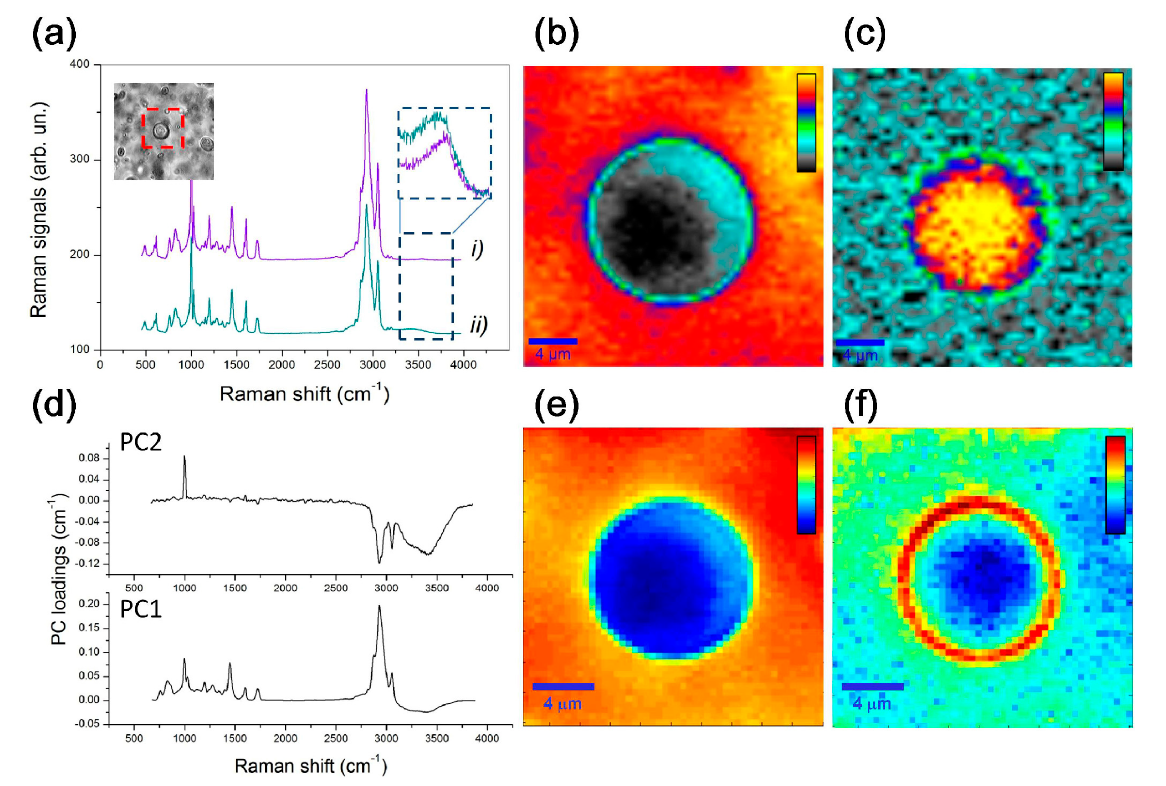
Figure 11. ( a ) Raman spectra obtained in a point external ( i ) and internal ( ii ) at the microvacuole. In the inset, an optical image of the microvacuole selected for Raman analysis in HFO. ( b ) Raman image of the microvacuole following the polymer band intensity (area) between 2800 and 2900 cm − 1 . ( c ) Water distribution inside the vacuole obtained by plotting the intensity of contributions in the 3200–3700 cm − 1 range. ( d ) Loading plot for the first (bottom) and second (upper) PC, resulting from analysis of spectra acquired in a raster scan around the vacuole. ( e , f ) PC1 and PC2 score map from PCA of Raman spectra. Reprinted from Ref. [44] under the terms of the OSA Open Access Publishing Agreement. © 2019 Optical Society of America.